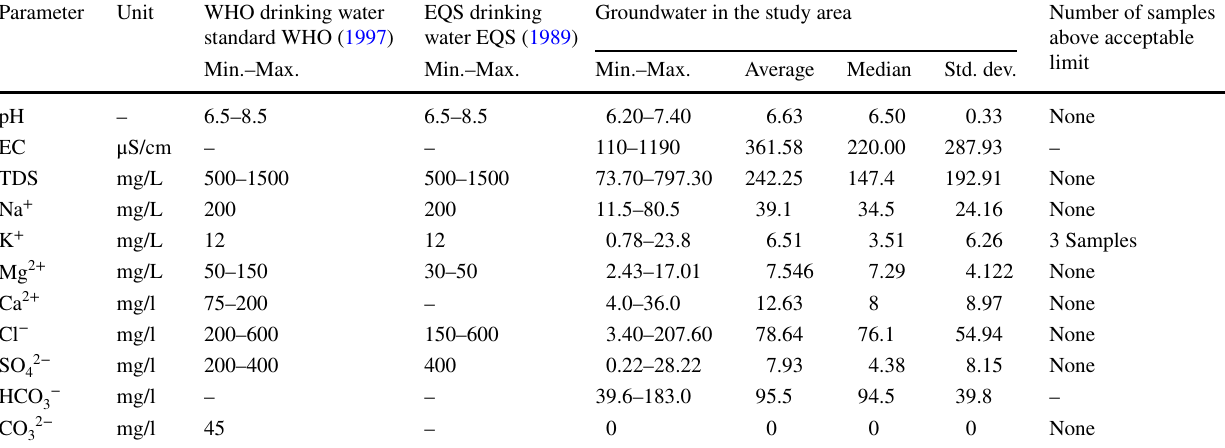
Table 2 Correlation between the groundwater samples of the study area with the standard limits prescribed by WHO (1997) and EQS (1989) for drinking water purposes Parameter